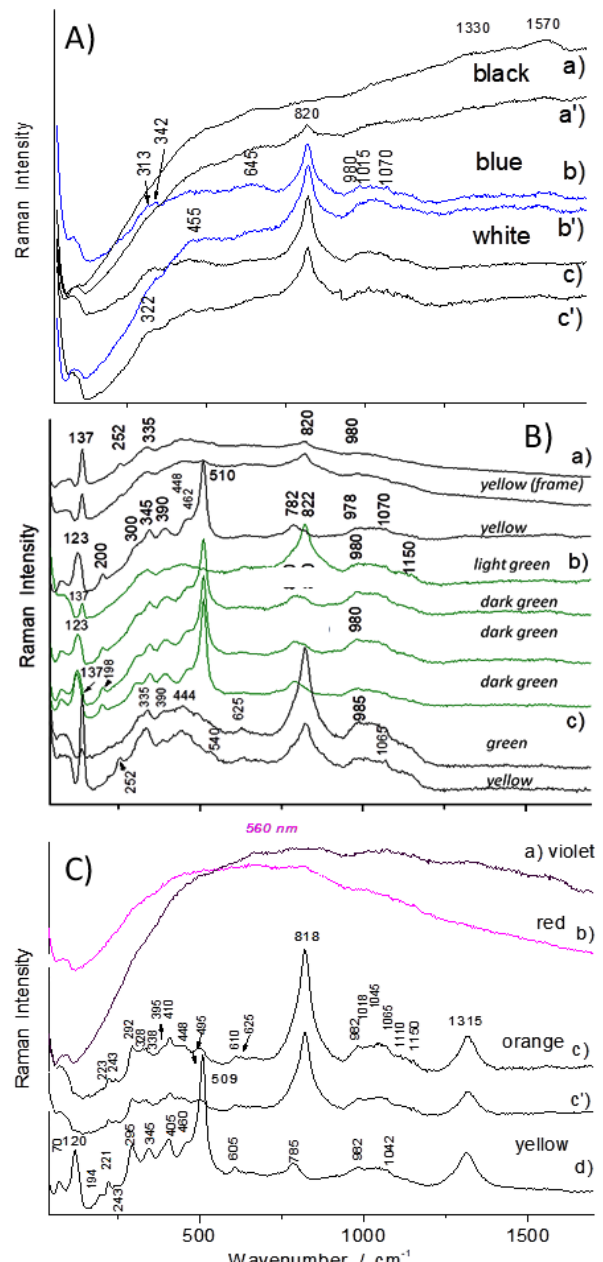
Figure 14. Representative Raman spectra recorded on the F1440C bottle (Qianlong period) for different coloured areas: white and blue (A), yellow and green (B) and special colours (C).